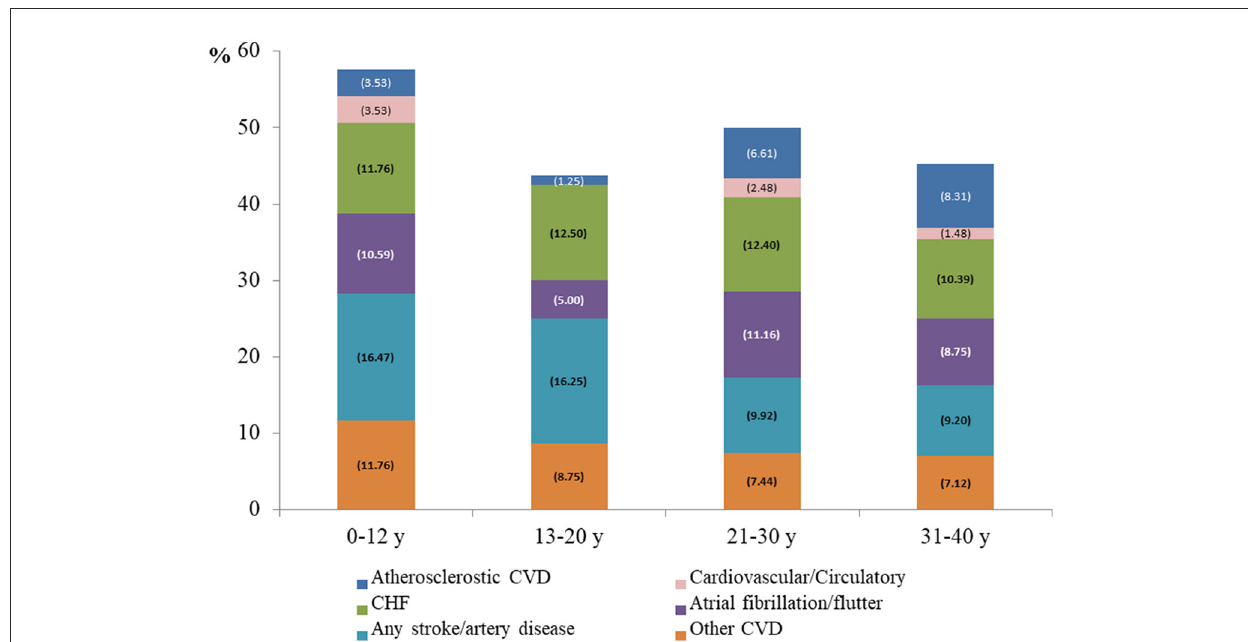
FIGURE4 Discharge diagnosis of cardiovascular disease among patients with in-hospital mortality Atherosclerotic CVD, coronary artery disease and infarction; Non-atherosclerotic CVD, cardiovascular/circulatory, (congestive) heart failure, atrial fibrillation/flutter, any stroke, artery disease; other CVD, other heart disease and valve